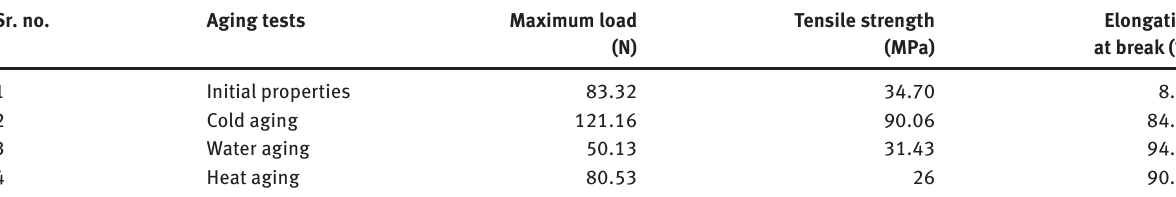
Table 10: Percentage increase in properties of coir fiber-reinforced vulcanized NR composites. Sr.